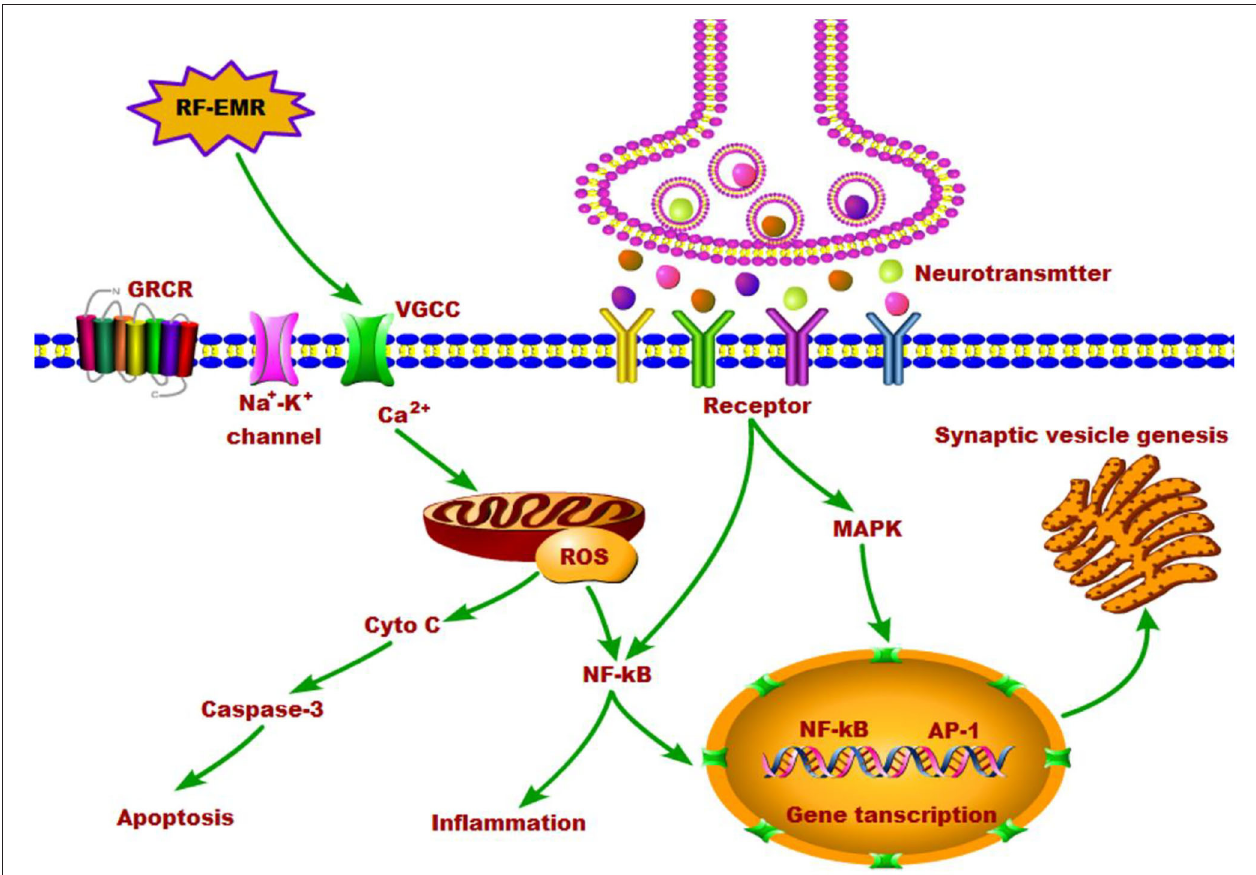
FIGURE 1 | The effects of RF-EMR exposure on neurotransmitters in the brain and the possible underlying